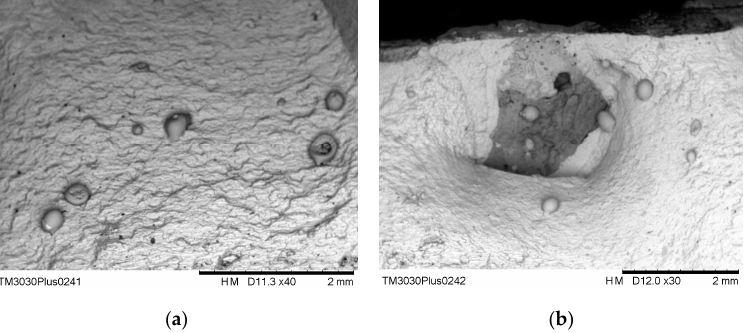
Figure 12. Scanning electron microscopy (SEM) of defects in the fracture zone of the specimen 766-FM-C: ( a ) inclusions in the propagation area; ( b ) large void in the crack initiation site. Defects evaluation for 766-FM-2 specimen, revealed different results (Figure 13).